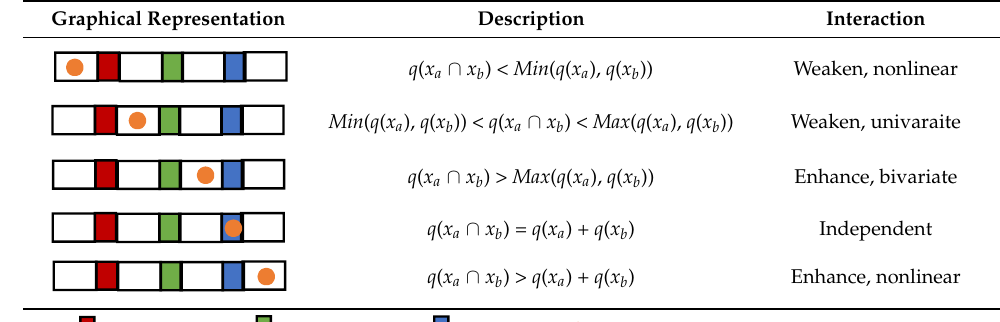
Table 2. Types of interaction between two covariates.